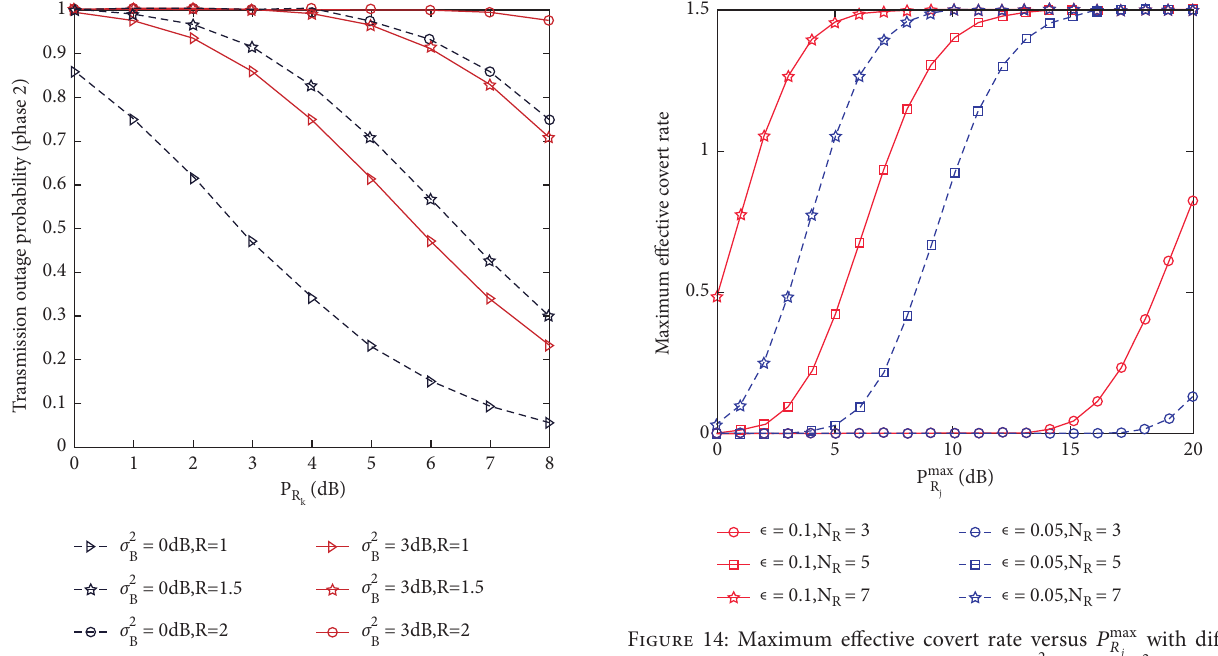
Figure 12: Transmission outage probability versus P ferent value of σ 2 B and R , where N R � 3.